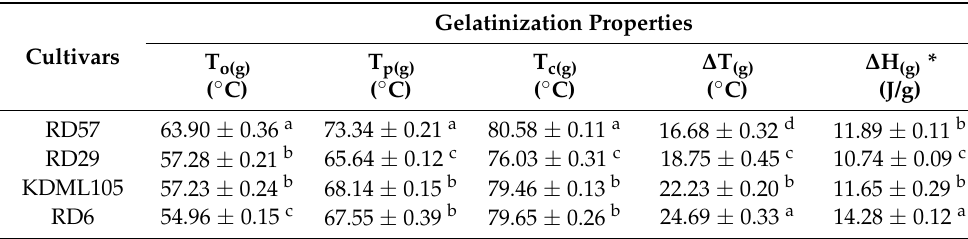
Table 4. Gelatinization properties of starches from four Thai commercial rice cultivars with different starch pasting properties.